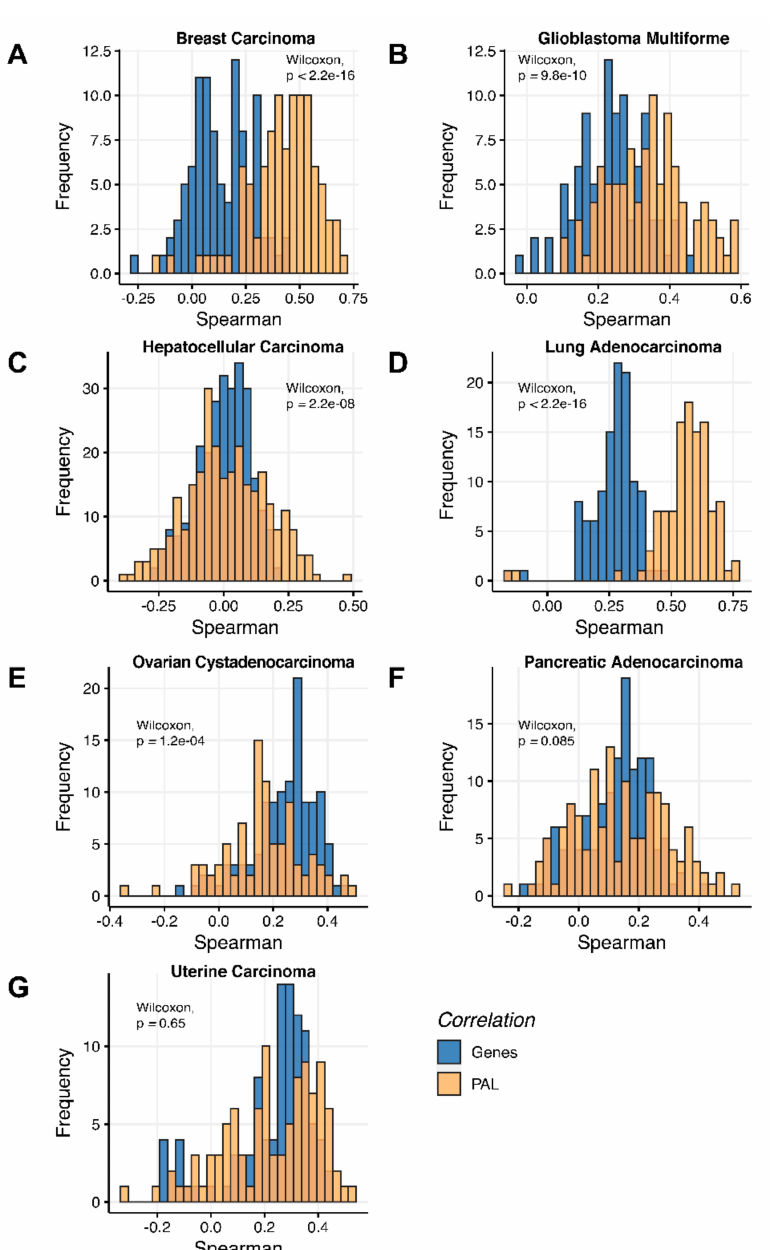
Figure 16. Gene-to-gene and PAL-to-PAL Spearman correlation between RNA and protein expression levels estimated by individual samples across ( A ) Breast Invasive Carcinoma, ( B ) Glioblastoma Multiforme, ( C ) Hepatocellular Carcinoma, ( D ) Lung Adenocarcinoma, ( E ) Ovarian Serous Cystade- nocarcinoma, ( F ) Pancreatic Ductal Adenocarcinoma and ( G ) Uterine Corpus Endometrial